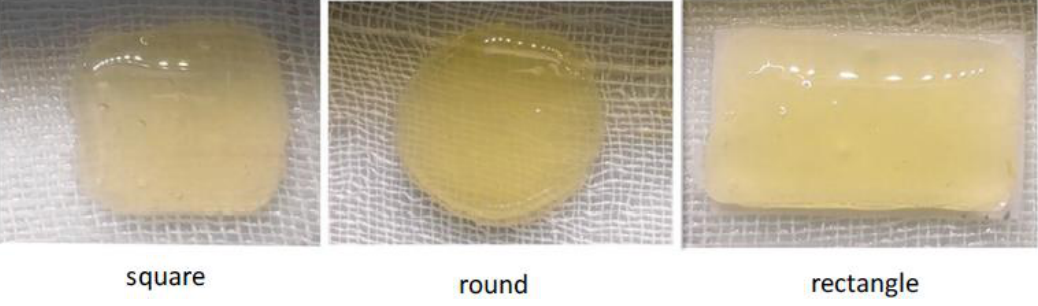
Figure 3. Three different shapes of polysaccharide hydrogel tablets for 3D printing (from Yang et al. [35], with permission).